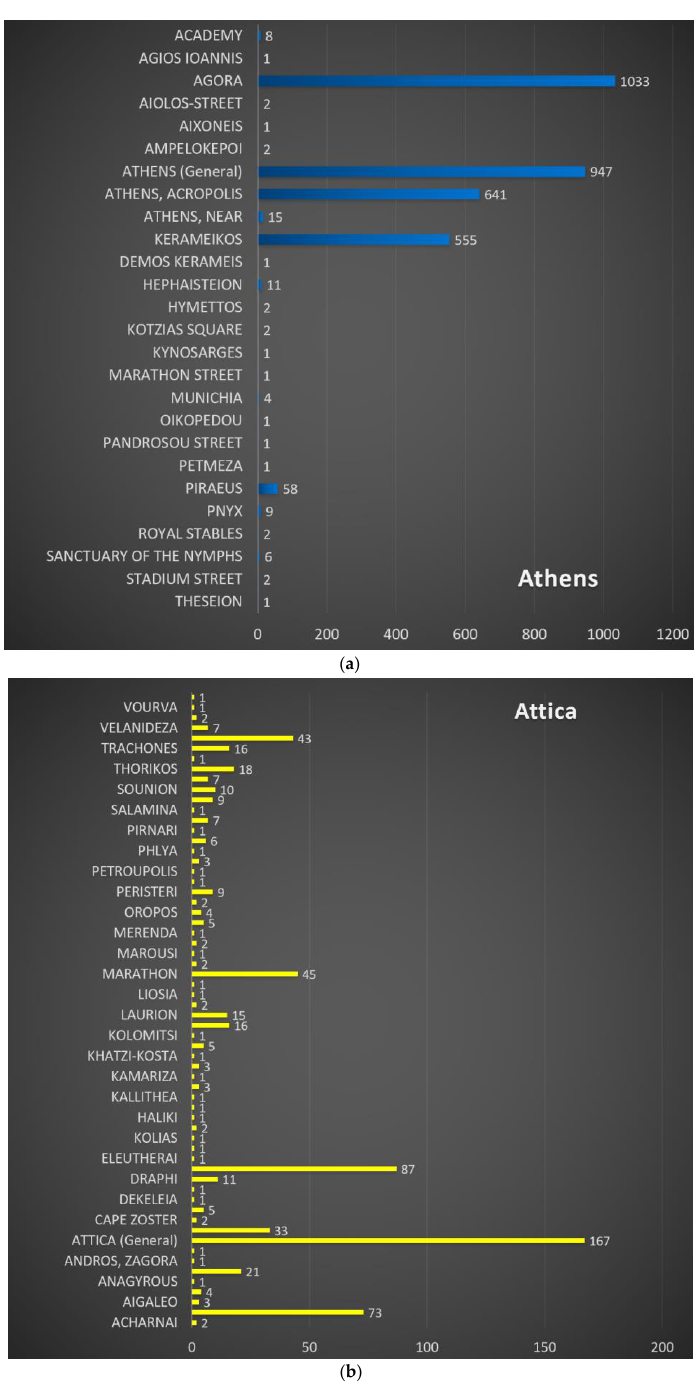
Figure 5. Known findspots of Athenian vases dating to the 5th century BCE including a depiction of woman from ( a ) within Athens and ( b ) Attica. Data from the BAPD. Charts created by